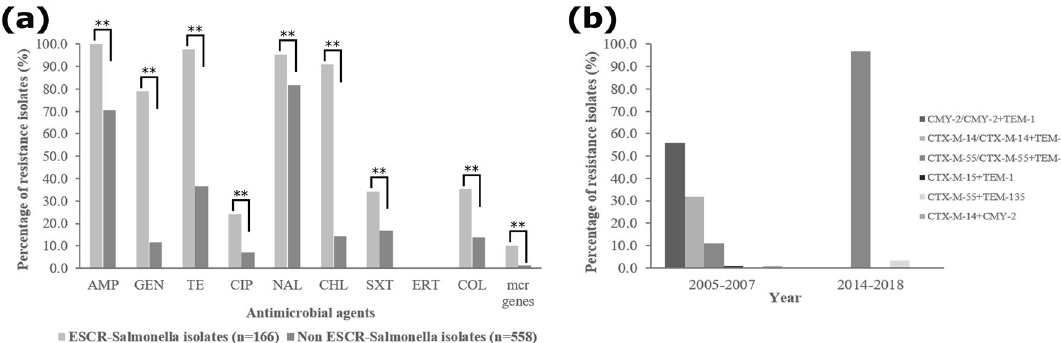
Figure 2. ( a ) Comparison of the AMR observed between ESC-resistant Salmonella and non ESC-resistant counterparts from the 724 nontyphoidal Salmonella isolated from patients in Thailand during 2005–2007 and 2012–2016. ( b ) Resistance mechanisms detected among ESC-resistant Salmonella isolates in 2005–2007 and 2014–2018. AMP ampicillin, GEN gentamicin, TE tetracycline, CIP ciprofloxacin, NAL nalidixic acid, CHL chloramphenicol, SXT trimethoprim-sulfamethoxazole, ERT ertapenem, COL colistin, ESCs extended-spectrum cephalosporins; *, p < 0.05; and **, p <